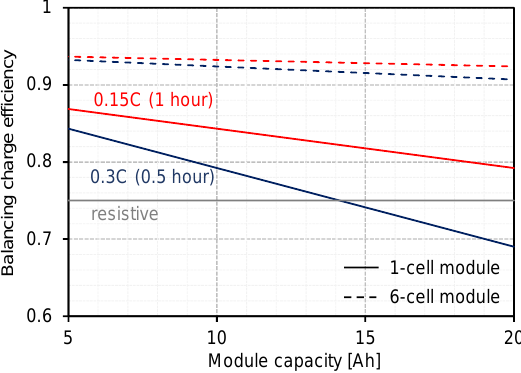
Figure 6. Balancing charge efficiency of the proposed SC equalizer at different currents and voltages.